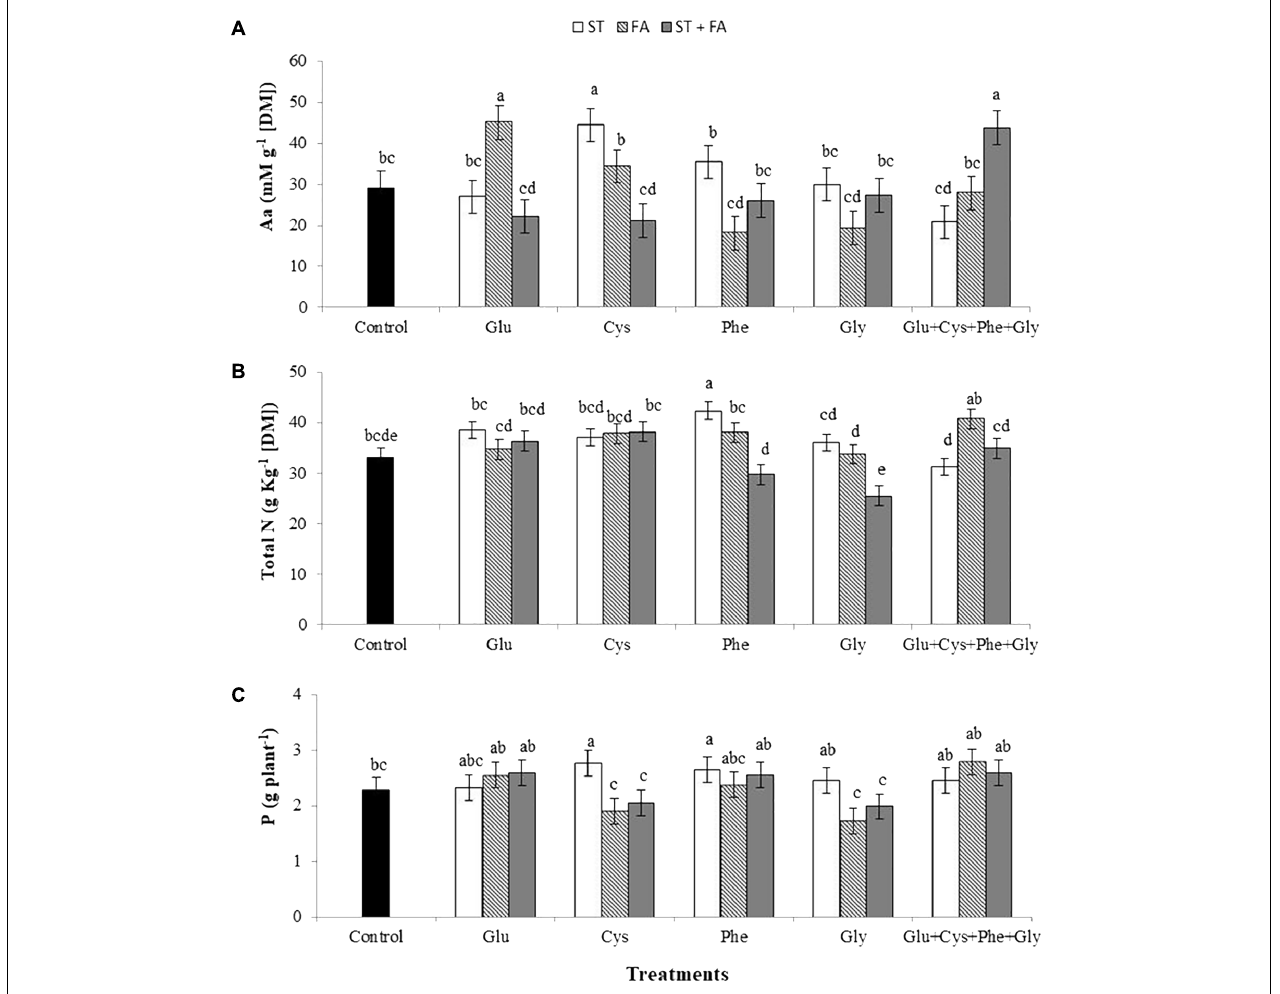
FIGURE 2 | Effects of use of glutamate (Glu), cysteine (Cys), phenylalanine (Phe), glycine (Gly) and all these amino acids in association (Glu+Cys+Phe+Gly), as function of seed treatment (ST) and/or foliar application (FA), on the total amino acid (Aa, A ) and total nitrogen (Total N, B ) at the V 6 stage and soybean productivity (P, C ). Greenhouse experiment. Season 2015/2016. Means followed by the same letters do not differ significantly from each other, using the Duncan test at 5%